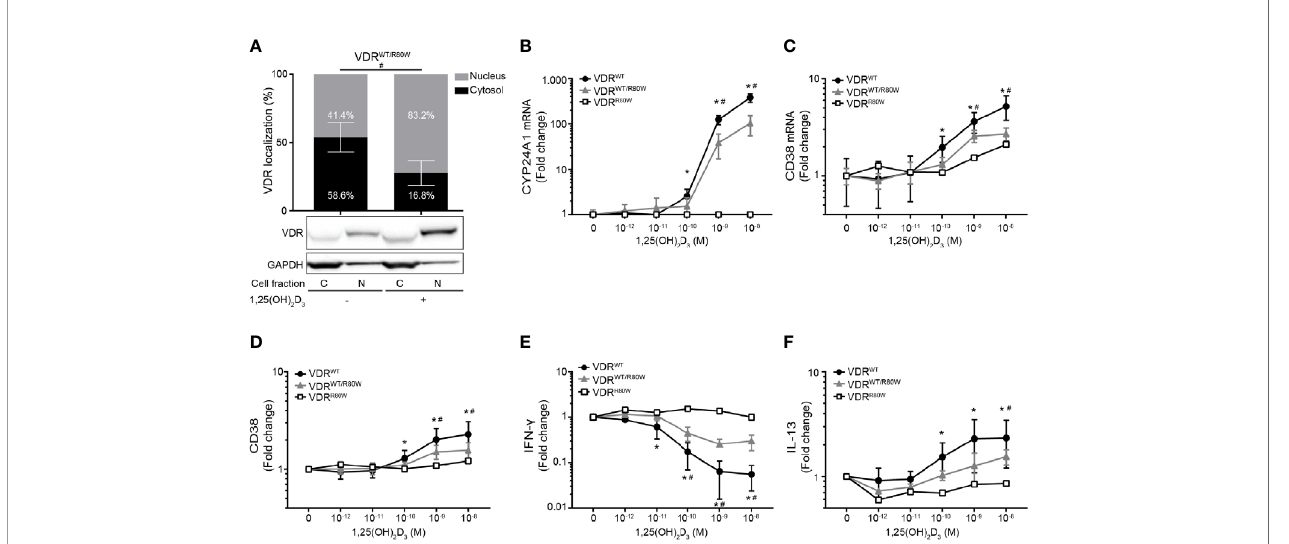
FIGURE 4 | Reduced responsiveness to 1,25(OH) 2 D 3 in T cells from heterozygous family members (A) Subcellular localization of the VDR in VDR WT/R80W heterozygous CD4 + T cells activated in the absence (-) or presence (+) of 1,25(OH) 2 D 3 (10 nM). The upper panel shows the fraction of VDR located to the nucleus and the cytosol in grey and black columns, respectively, as determined by the density of the VDR bands from the Western blotting analysis. The lower panels show one representative Western blotting analysis out of four independent experiments of VDR and GAPDH (loading control) from the cytosolic (C) and nuclear (N) fraction. Mean ± SD (VDR WT/R80W n = 4; # p < 0.05). (B) CYP24A1 and (C) CD38 mRNA expression, (D) CD38 cell surface expression, (E) IFN- g and (F) IL-13 production in VDR WT (black circles), VDR WT/R80W (gray triangles) and VDR R80W (white squares) CD4 + T cells activated in the presence of the indicated concentration of 1,25(OH) 2 D 3 . The expression levels are given as fold change normalized to the average expression level of the given molecule in cells activated in the absence of 1,25(OH) 2 D 3 in each group. Mean ± SD (VDR WT n = 13; VDR WT/R80W n = 4; VDR R80W n = 1; *VDR WT p < 0.05 compared to VDR WT in the absence of 1,25(OH) 2 D 3 , # VDR WT/R80W p < 0.05 compared to VDR WT/R80W in the absence of 1,25(OH) 2 D 3